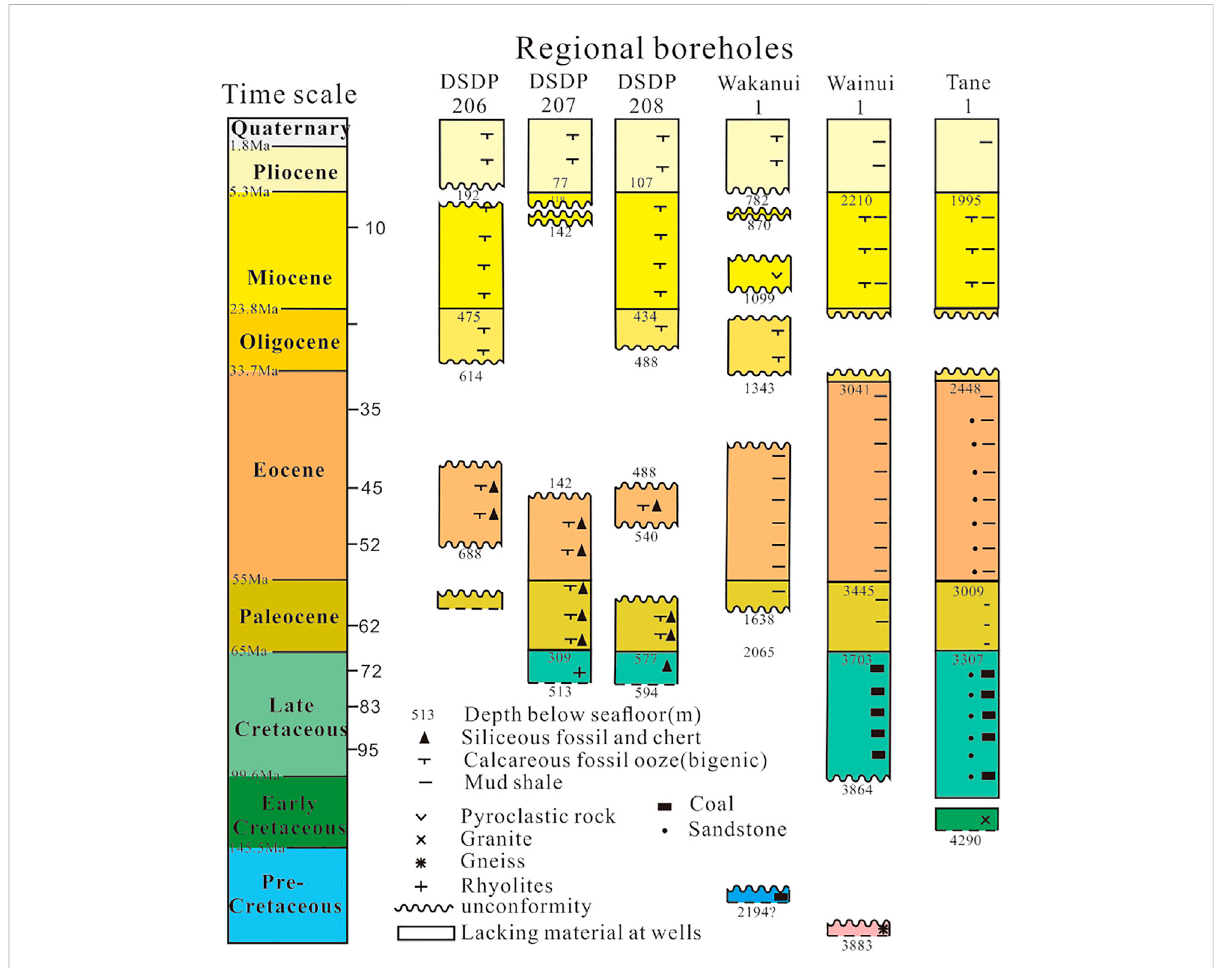
FIGURE 2 Comprehensive histogram of formation drilling (Willcox and Sayers, 2002; Stagg et al., 2002; Van de Beuque et al., 2003; Collot et al.,